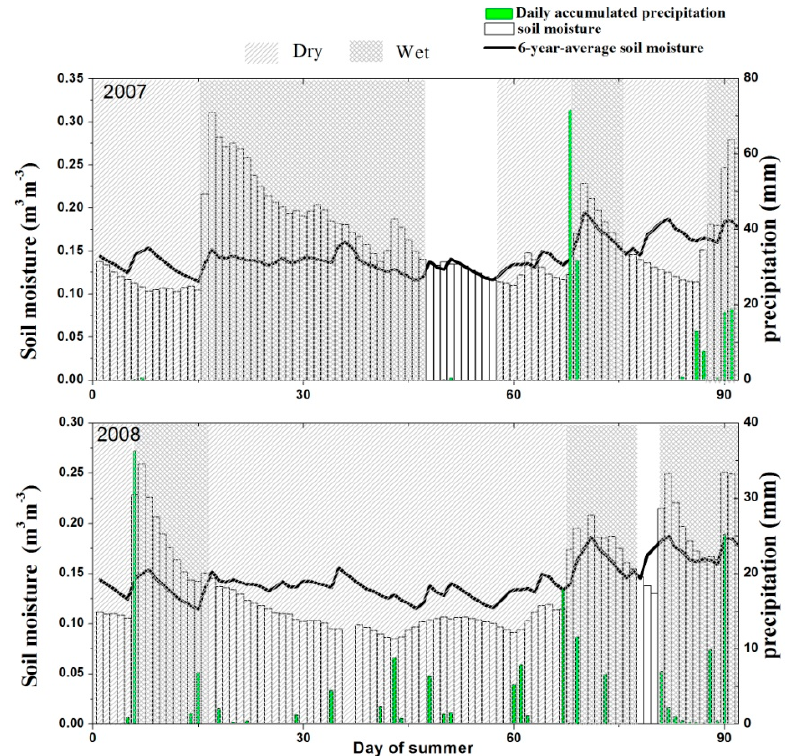
Figure 1. Six-year-average (2007–2012) soil moisture (black line) and the daily average of soil moistureduring the summer of 2007–2008 (hollow bars), and daily accumulated precipitation during the summer of 2007–2008 (green bars).